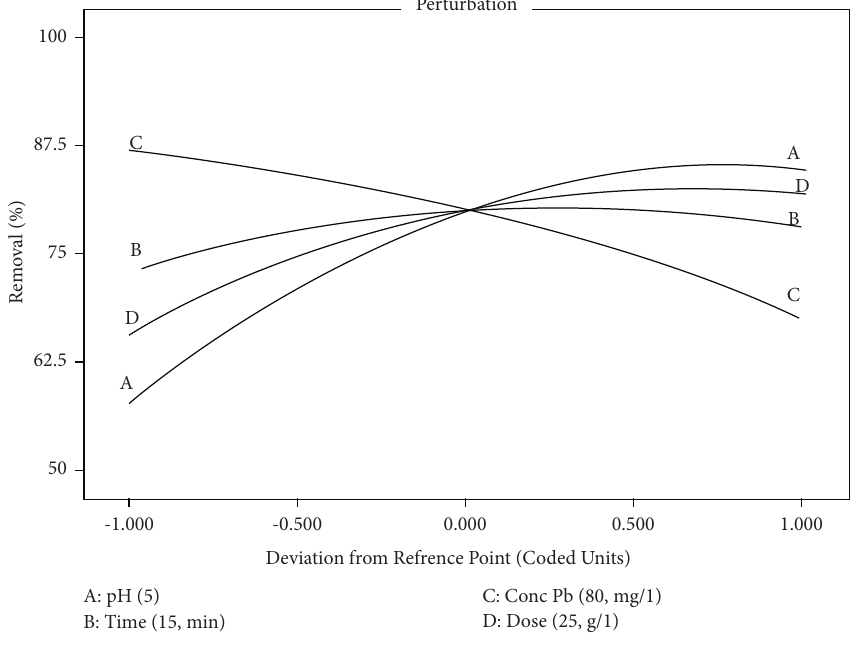
Figure 4: Parameters perturbation for TT powder. Table 4: Software optimized points for adsorbents.